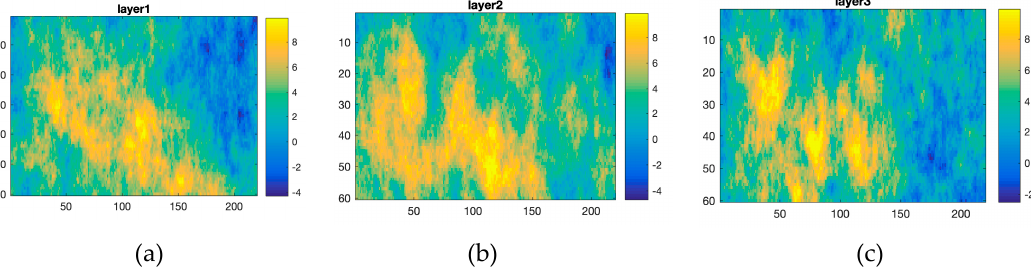
Figure 8. Logarithmic of permeability field in the 3D two-phase flow reservoir model. ( a ) First layer; ( b ) Second layer; ( c ) Third Layer.